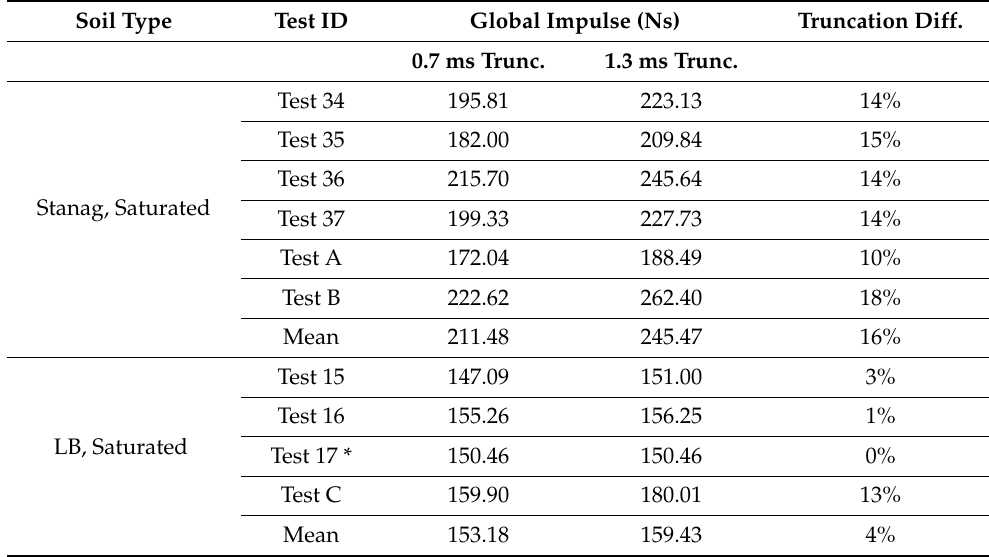
Table 3. Global impulse results without area limiting for 0.7 ms and 1.3 ms truncations of signals from CoBL. * Test 17 data show no difference between truncation times as it was only recorded up to 0.5 ms.